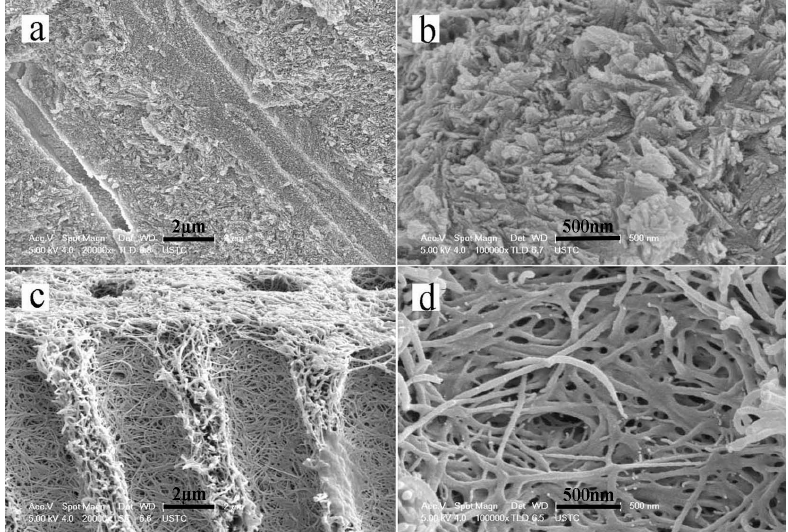
Figure 2. Scanning electron microscopy (SEM) micrographs showing a cross ‐ sectional view of sound